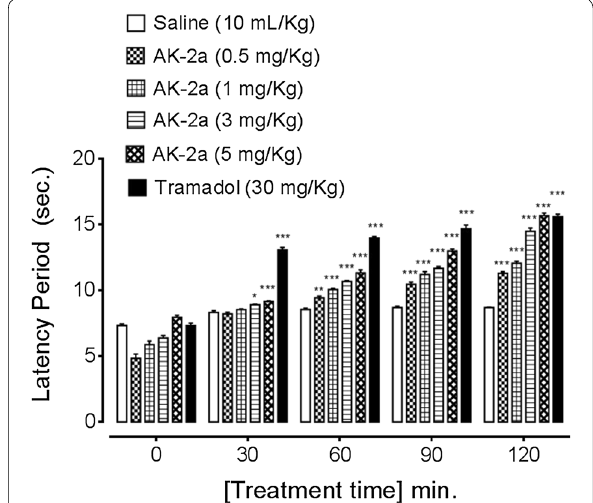
SEM, n 5. * P < 0.05, ** P < 0.01 and ± = 9.17 s ( P < 0.001 vs. saline ±